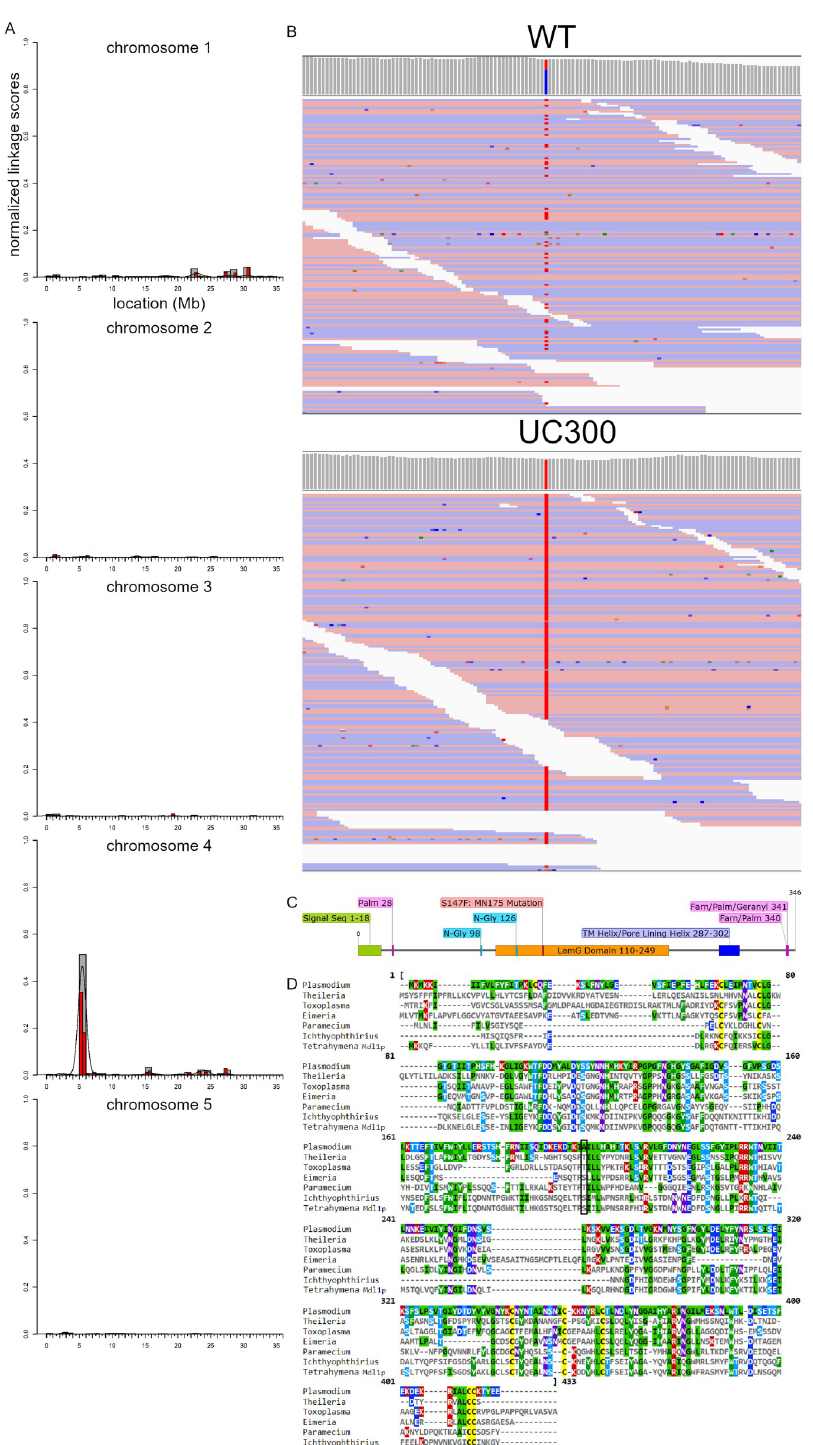
Fig 2. Mdl1p structure and expression. A. The results of mapping of the causal DNA sequence variant for MN175 using ACCA [60]. Normalized linkage scores are shown along all five micronuclear chromosomes. Allelic cosegregation is increased on Chr 4 3-9Mb. B. Comparison (generated with IGV [http://software.broadinstitute.org/ software/igv/]) between F2 pools with WT or MN175 phenotypes, of aligned sequencing reads around chr4: 5,364,873 (highlighted). At this site, reference read is G (blue) and variant read is A (red). C. Predicted features of